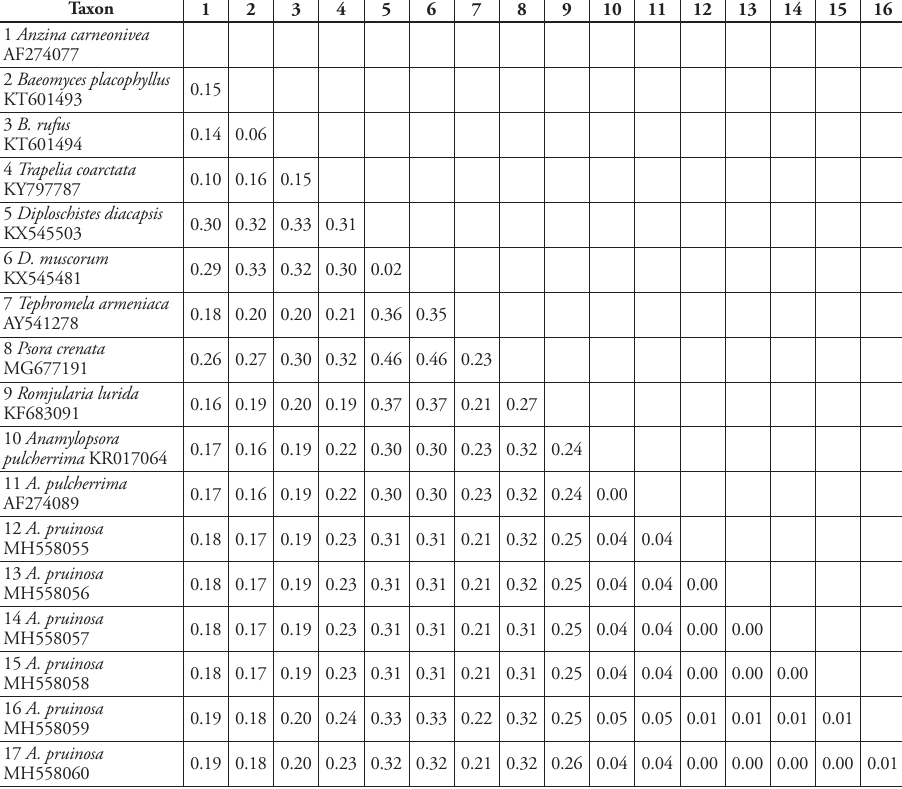
Table 2. Intraspecific and interspecific genetic distances range of the species in this study.